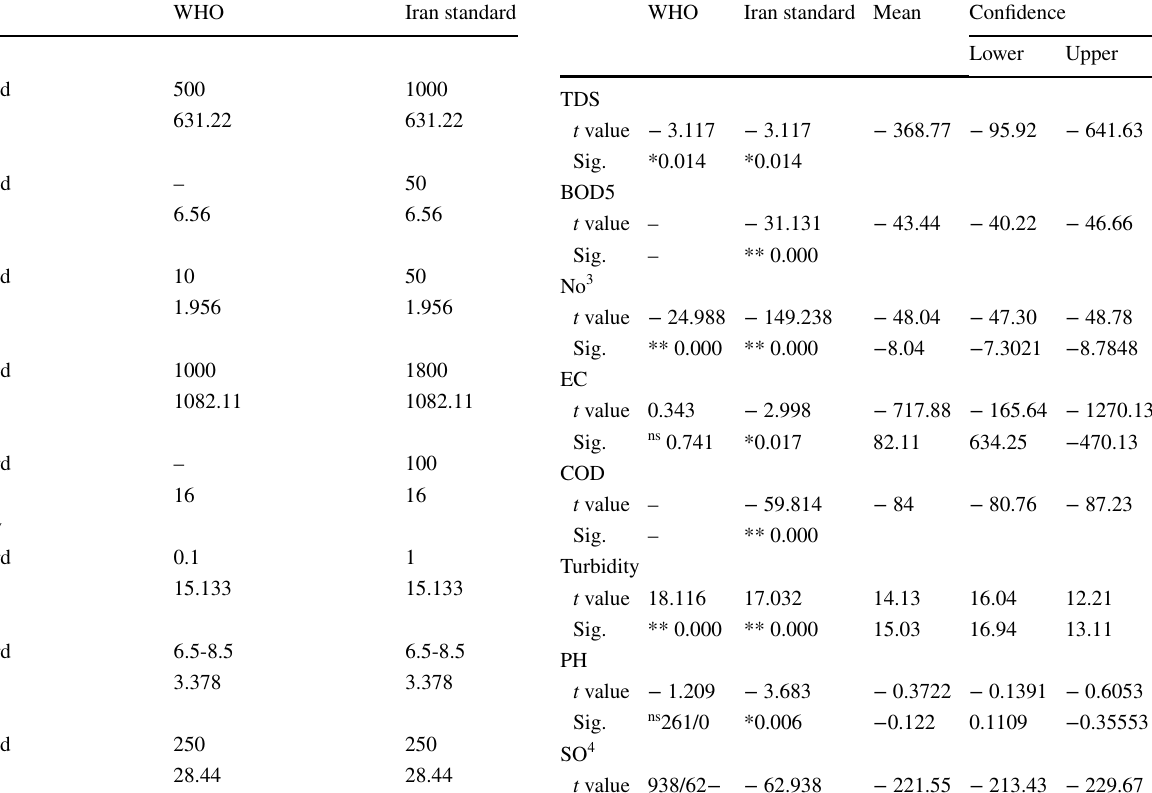
Table 6 One-sample t test to compare the physicochemical values of Balikhlou River water with national and international standards in high-water season